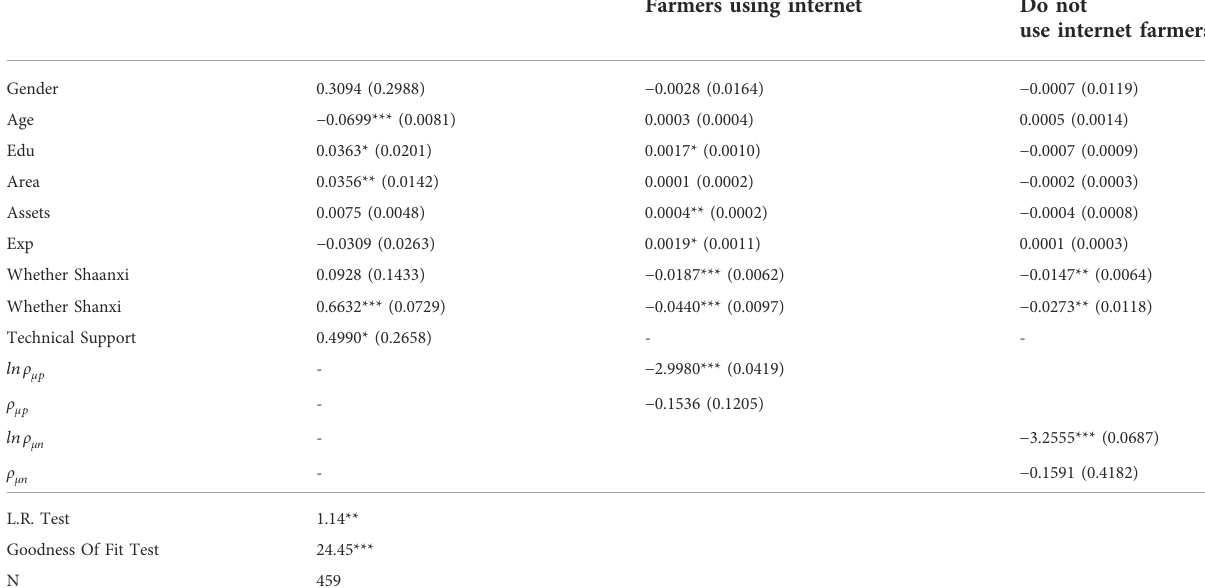
TABLE 7 Regression results of robustness test (1).